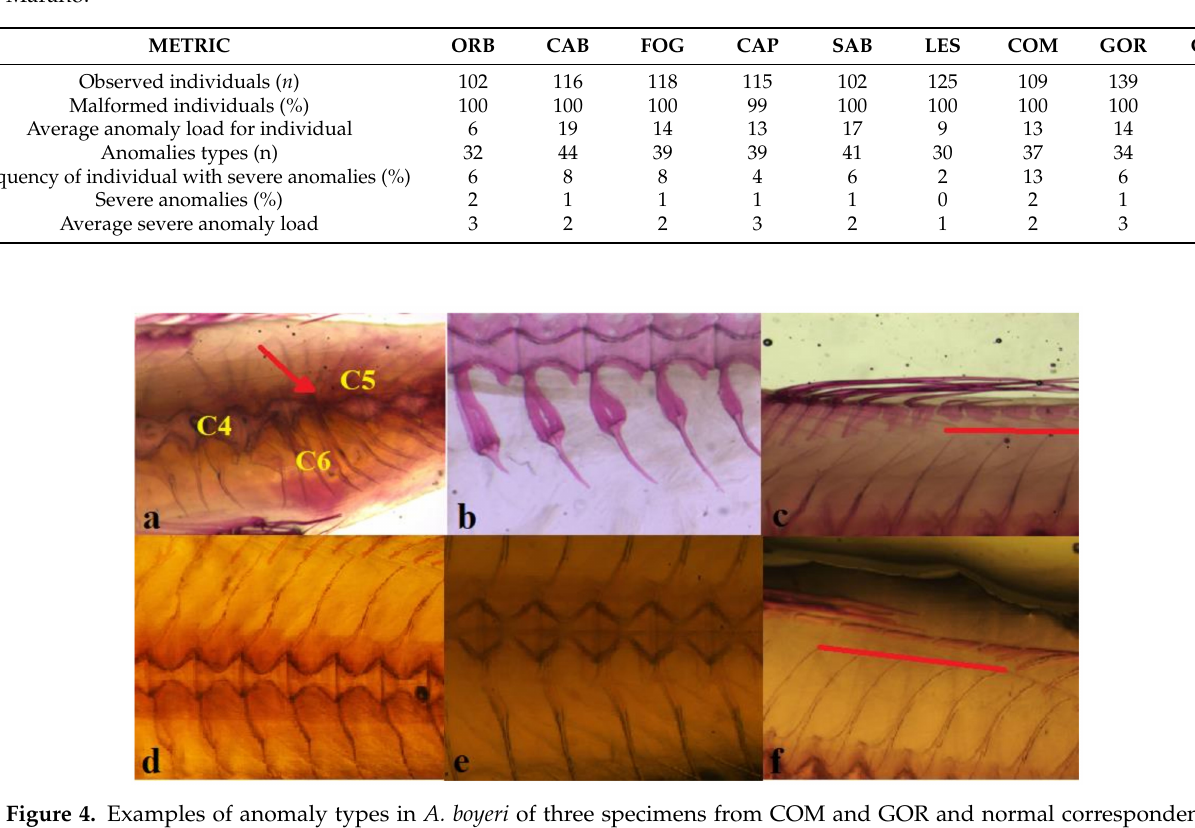
Figure 4. Examples of anomaly types in A. boyeri of three specimens from COM and GOR and normal correspondent structure from ORB, COM and GOR ( a ) Red arrow points at a multiple vertebrae fusion (C3); C4: malformed vertebral centrum; C5: malformed neural arches and spines; C6: malformed hemal arches and spines (0.8 × ). ( b ) Tulip-shaped hemal arches (C6T) in A. boyeri from ORB (1.2 × ). ( c ) Anomalous interdorsal skeletal elements (underlined by the red line) in A. boyeri from COM (1.2 × ). ( d ) Normal vertebral body and neural arches in an ORB specimen (1.2 × ). ( e ) Normal hemal arches in a COM specimen (1.2 × ). ( f ) Normal interdorsal elements in a GOR A. boyeri (1.2 ×